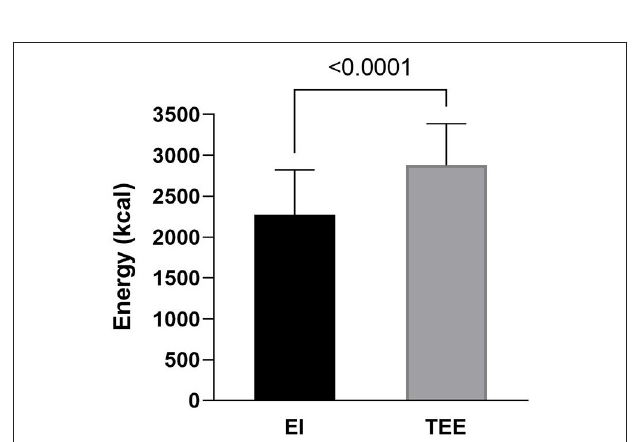
FIGURE 4 | Three-day average energy intake (EI) ( n = 26) and total energy expenditure (TEE) ( n = 27). Error bars denote SD.